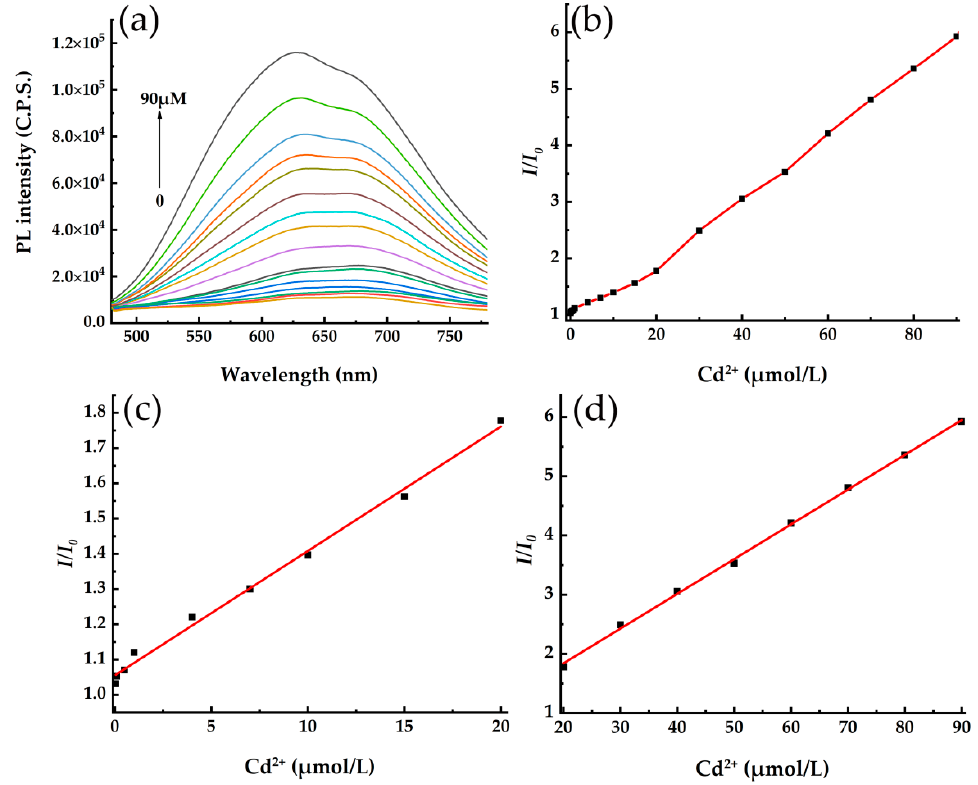
Figure 8. ( a ) The fluorescence spectra of EDTA ‒ CdSe/CdS+Cd 2+ QDs system with the various Cd 2+ concentrations, and the relationship between fluorescence intensity ratio ( I/I 0 ) and Cd 2+ concentration in the detected solution, ( b ) 0 ‒ 90 µmol/L, ( c ) 0 ‒ 20 µmol/L, and ( d ) 20 ‒ 90 µmol/L.